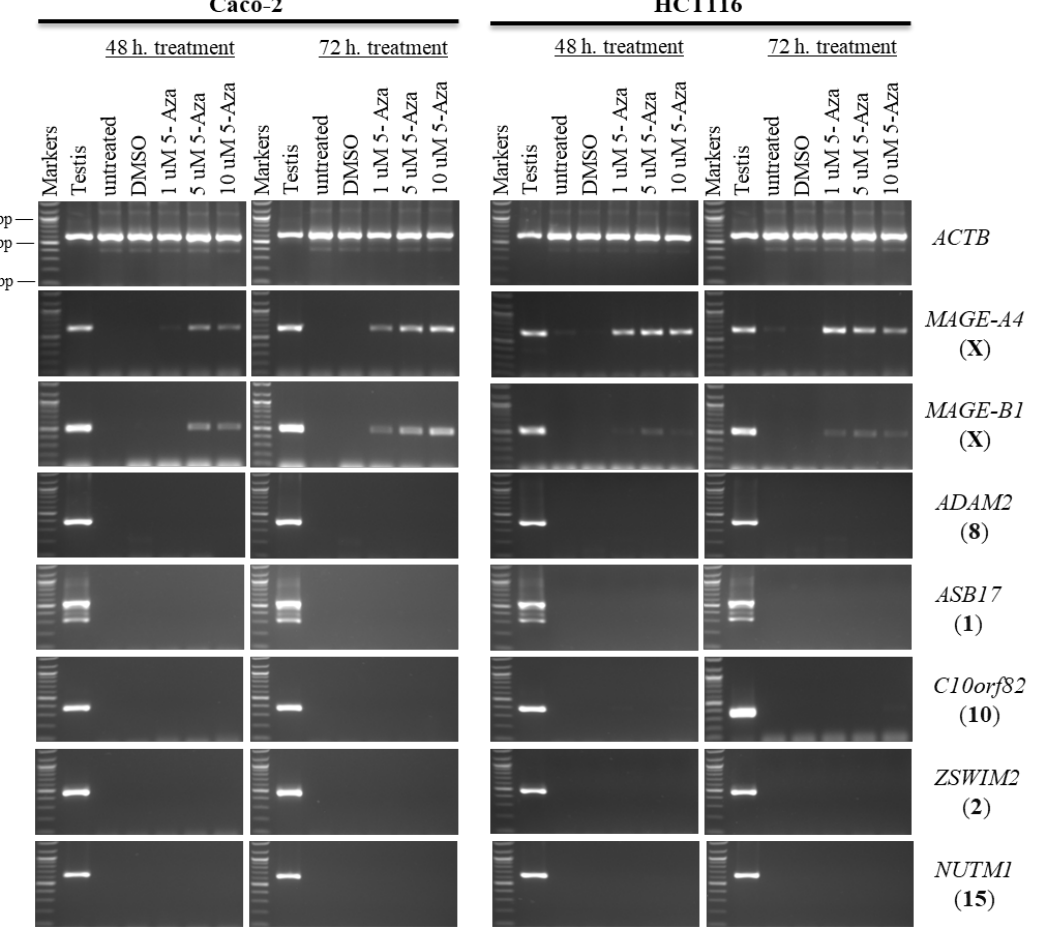
Figure 6. The effects of 5-aza-CdR treatments on testis-specific gene expression profiles in the Caco-2 and HCT116 cancer cell lines. The expression of ADAM2 , ASB17 , C10orf82 , ZSWIM2 , and NUTM1 genes is shown on agarose gels following treatment with various doses of 5-aza-CdR for 48 h (left column of each cell) or 72 h (right column of each cell). Untreated Caco-2 and HCT116 cells were used as controls to compare the expression of CT genes with treated cells, and a testis sample served as a positive control for primer efficiency. The control Caco-2 and HCT116 cells were treated with DMSO, as DMSO was the solvent used in the 5-aza-CdR solution. The positive control for the cDNA samples is the expression of the ACTB gene. The official names of the genes are written to the right of the agarose gel images, and the location of each gene on the chromosomal is written in parentheses on the right. Above each lane, the particular concentration of 5-aza-CdR (1, 5, and 10 µ M) is